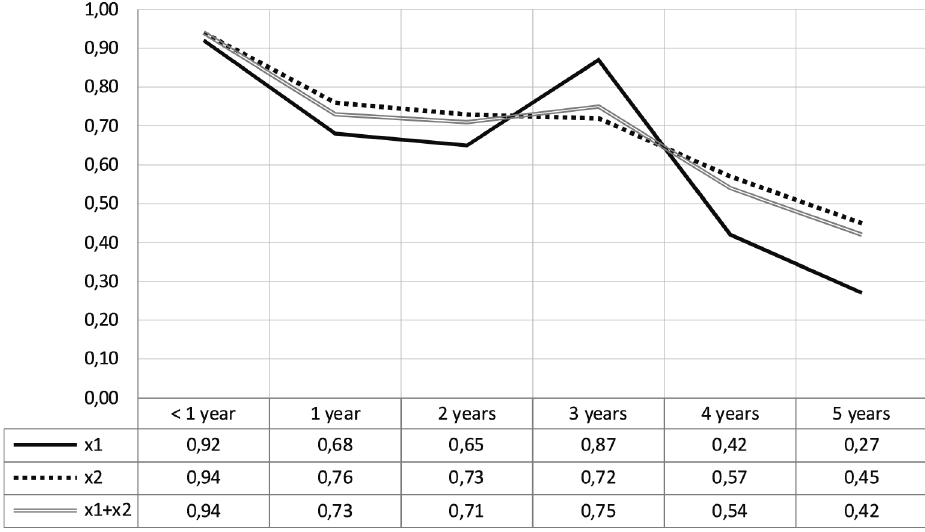
Figure 2. Summary of the SOSE in 2013−2018 in the studied